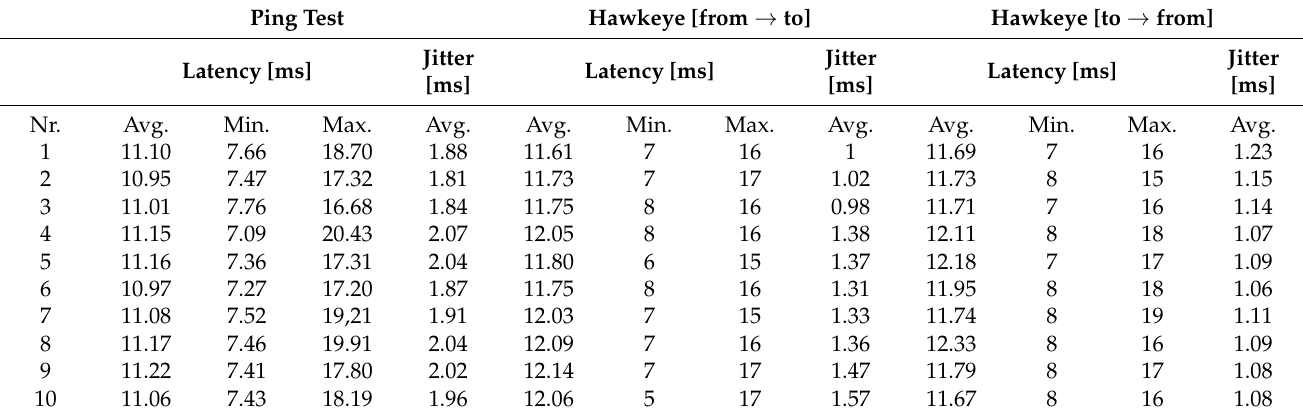
Table 2. Latency and jitter results from ping and Hawkeye test in